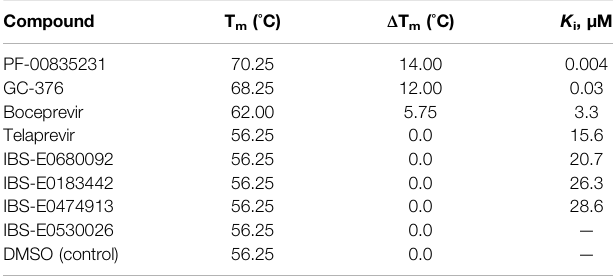
TABLE 4 | Changes in the M pro melting temperature upon the inhibitor binding, and inhibition constants of the tested compounds. Compound